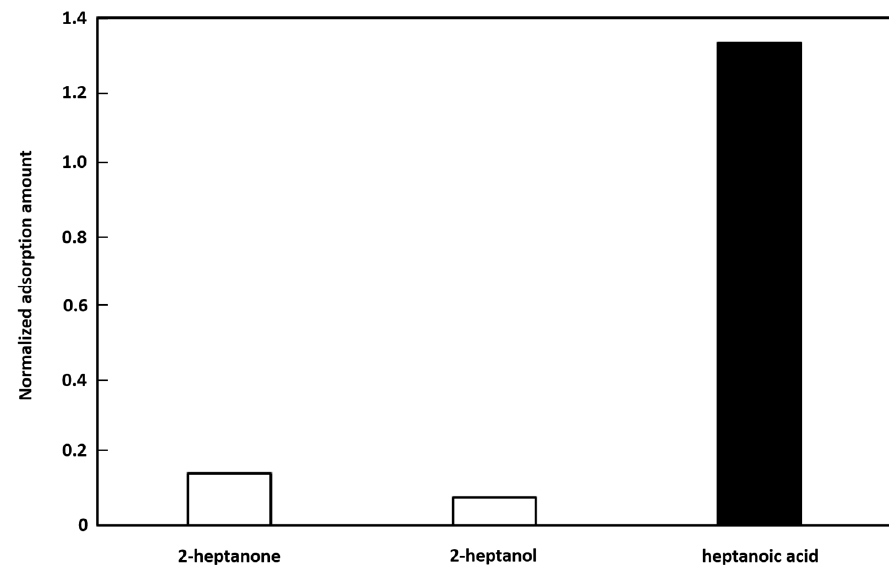
Figure 8. Adsorption specificity of a molecularly imprinted filtering adsorbent on a polydimethylsiloxane–divinylbenzene (PDMS-DVB) adsorbent layer. The template odorant was heptanoic acid.